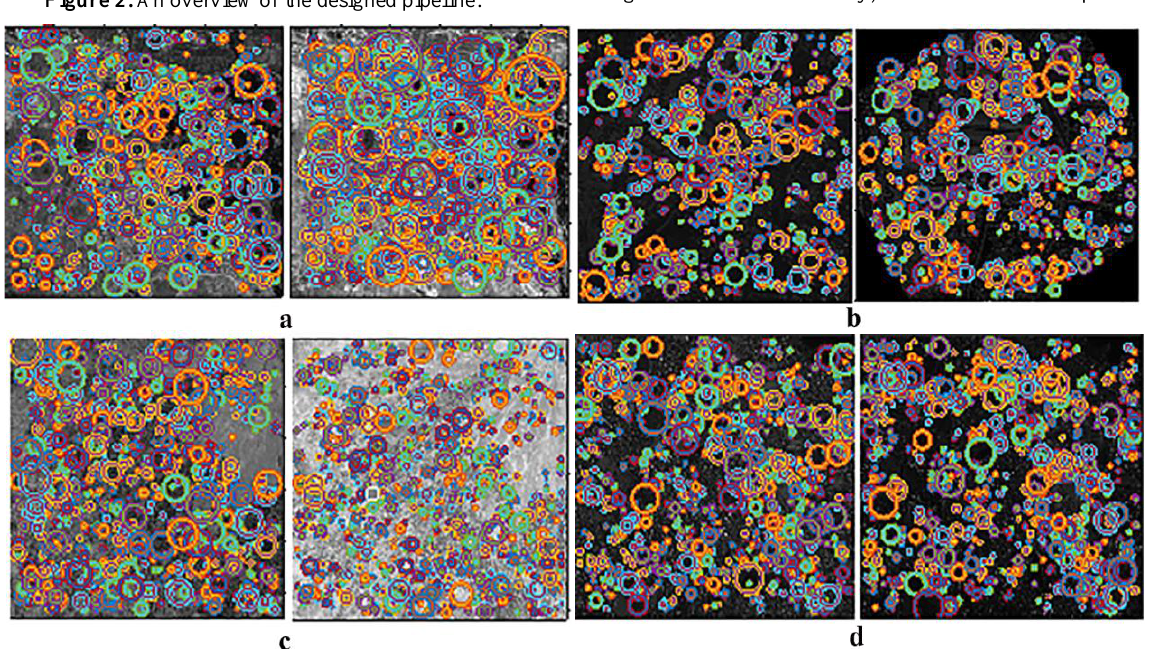
Figure 2. An overview of the designed pipeline.